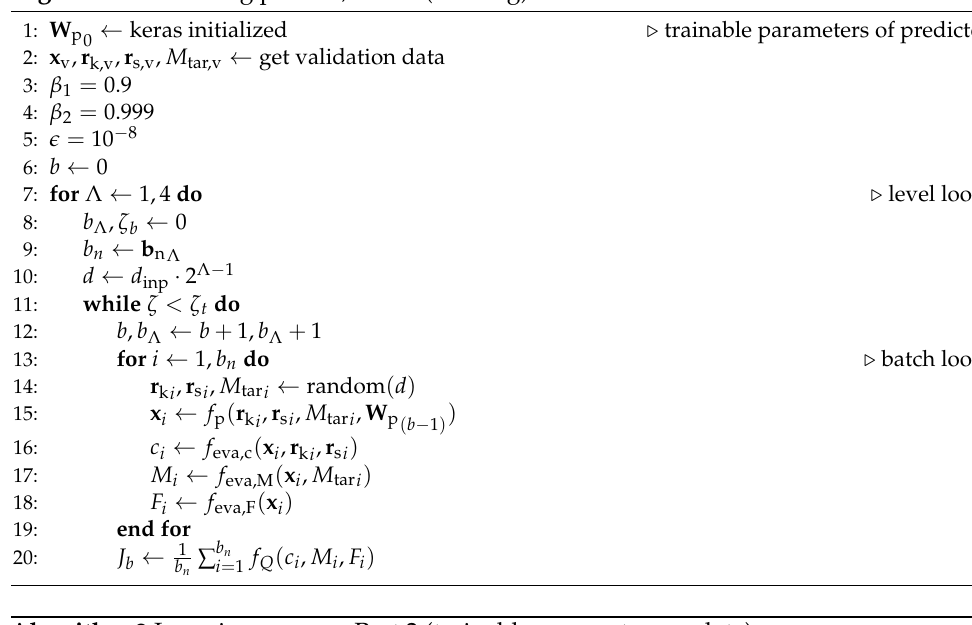
Algorithm 2 Learning process, Part 2 (trainable parameters update)